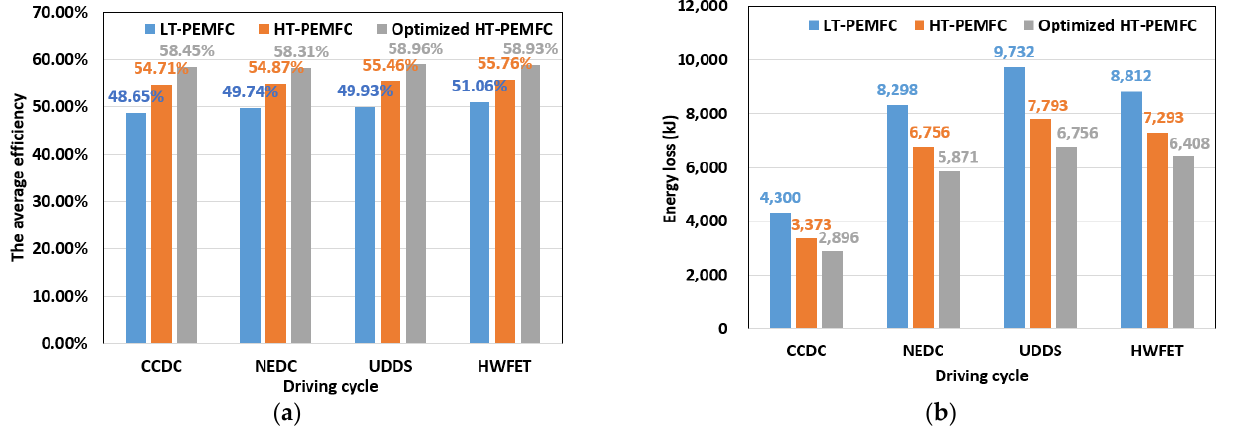
Figure 8. Comparison of fuel cell system efficiency and energy loss: ( a ) Efficiency; ( b ) Energy loss.